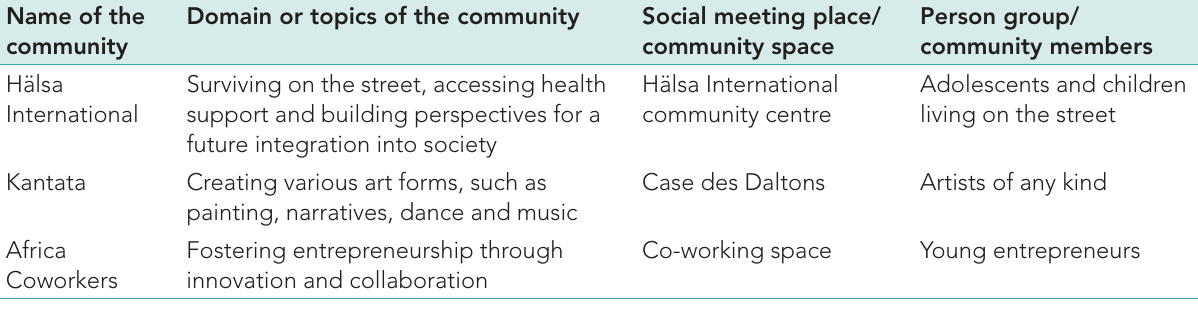
Table 1: Characteristics of the communities (Source: Data based on Wenger et al., 2002)